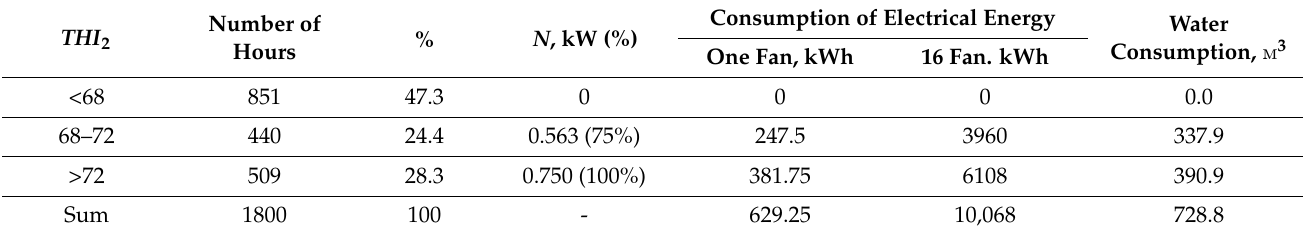
Table 4. Analysis of energy costs of the cooling system when regulated by using